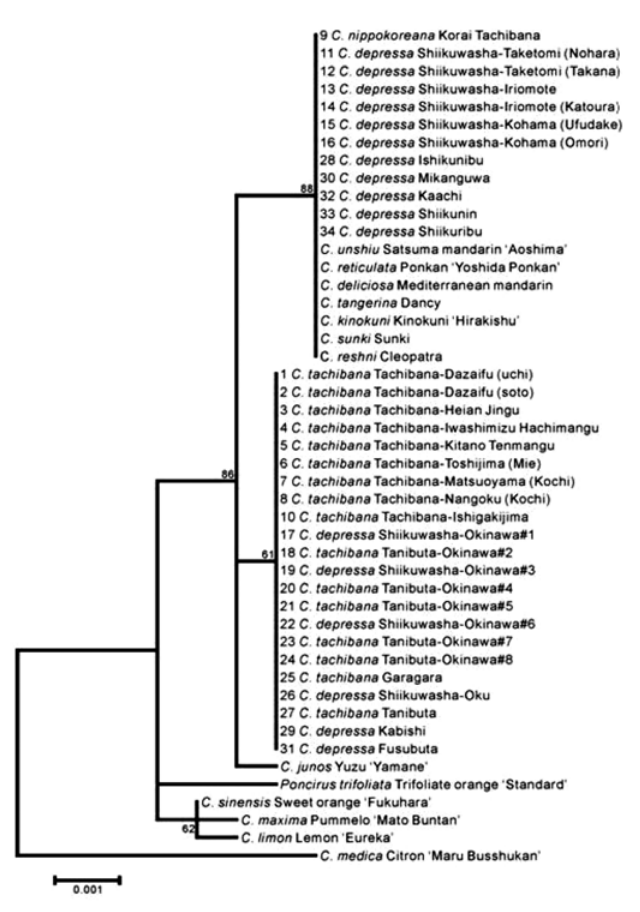
Fig. 2 - Maximum likelihood tree of the matK genes from Citrus tachibana , C. nippokoreana , and C. depressa and their control accessions. Numbers at the nodes indicate bootstrap values (% over 1000 replicates). The scale bar shows the number of sub- stitutions per